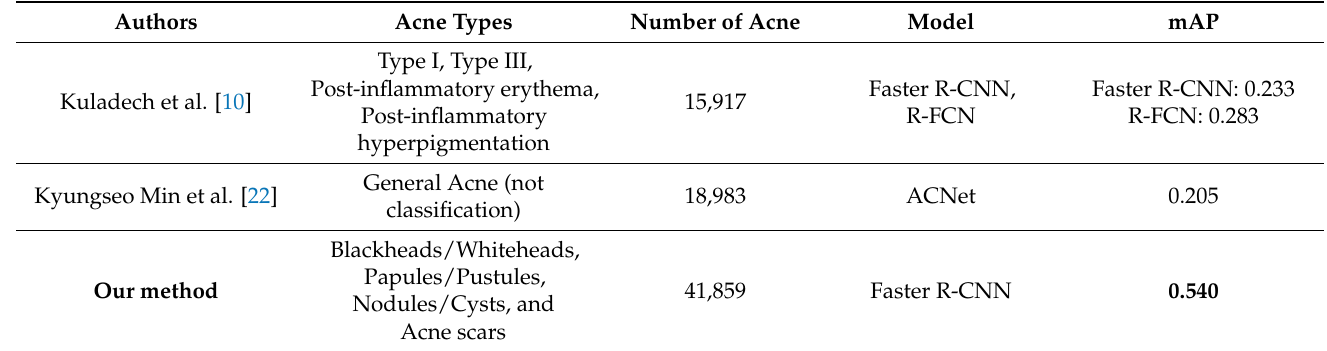
Table 6. Comparison of the mAP in detecting acne objects obtained in our study and in previous